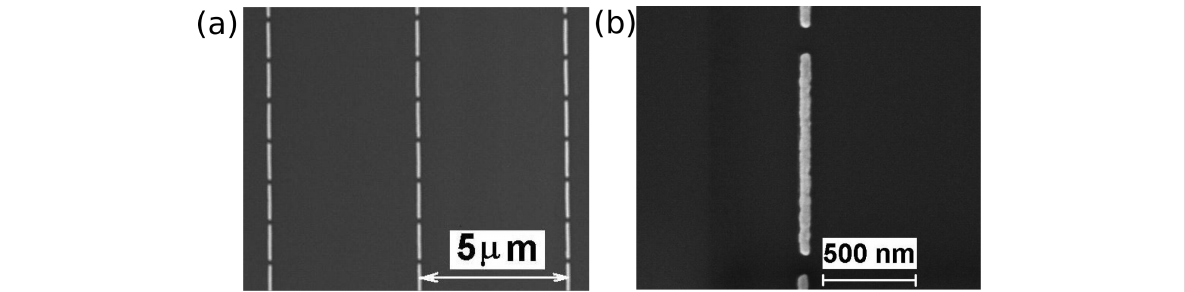
Figure 1: (a) Representative SEM image of Au nanoantenna array; nanoantenna length 900 nm. (b) Detailed image of a nanoantenna.